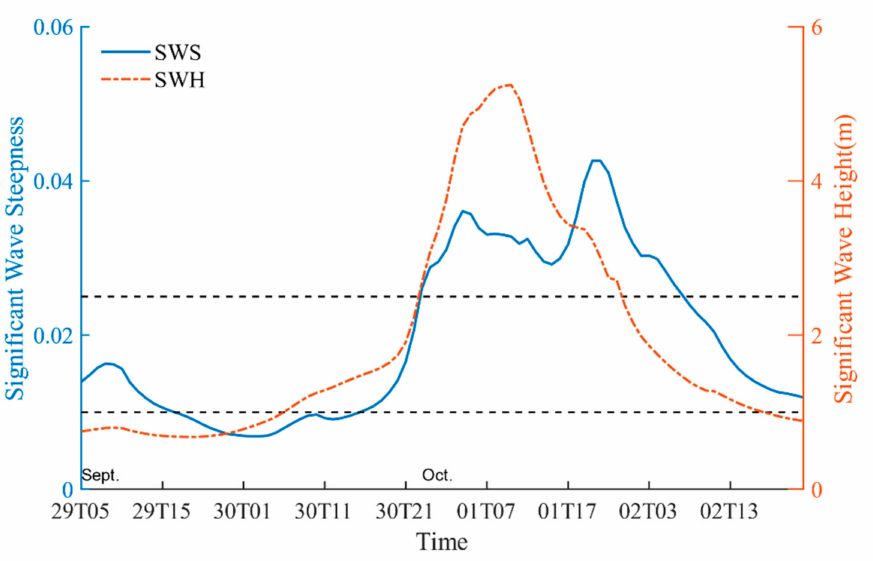
Figure 4. Significant wave steepness (SWS) and significant wave height (SWH). (Two black dash lines are SWS equals 1/100 and